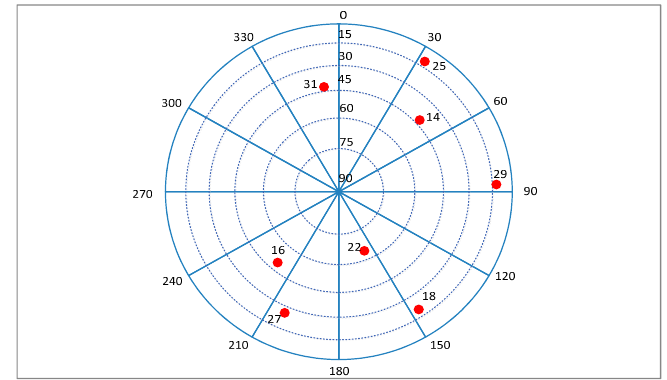
Figure 17. Sky plot of the satellites in Trajectory 1.